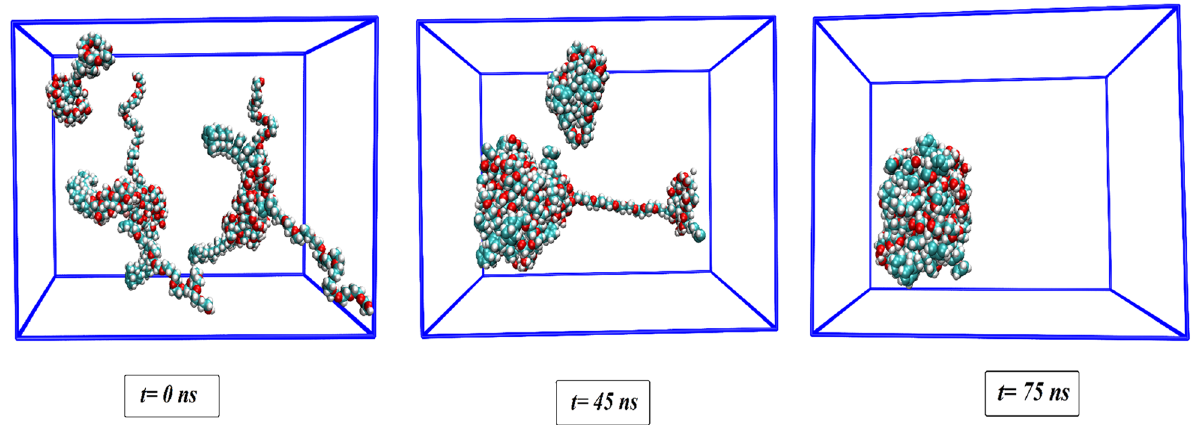
Figure 2. Trajectory snapshots of PS-β-CD/PE-FE aggregation. The MD trajectories are further viewed and analyzed with VMD (ver 1.9.3) and GROMACS tools (https:// www. ks. uiuc. edu/ Resea rch/ vmd and http:// www. groma cs.